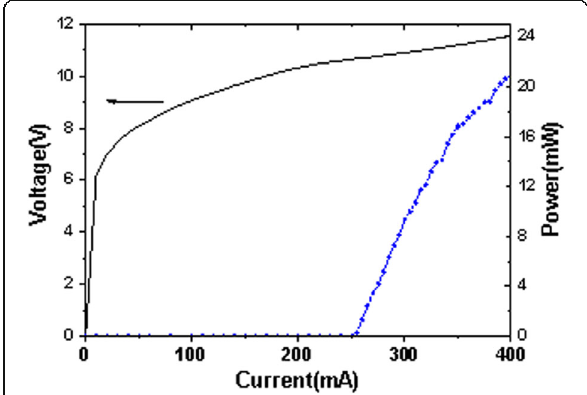
Fig. 3 The P-I-V characteristics of the EC-QCL in the central region at 2180 cm − 1